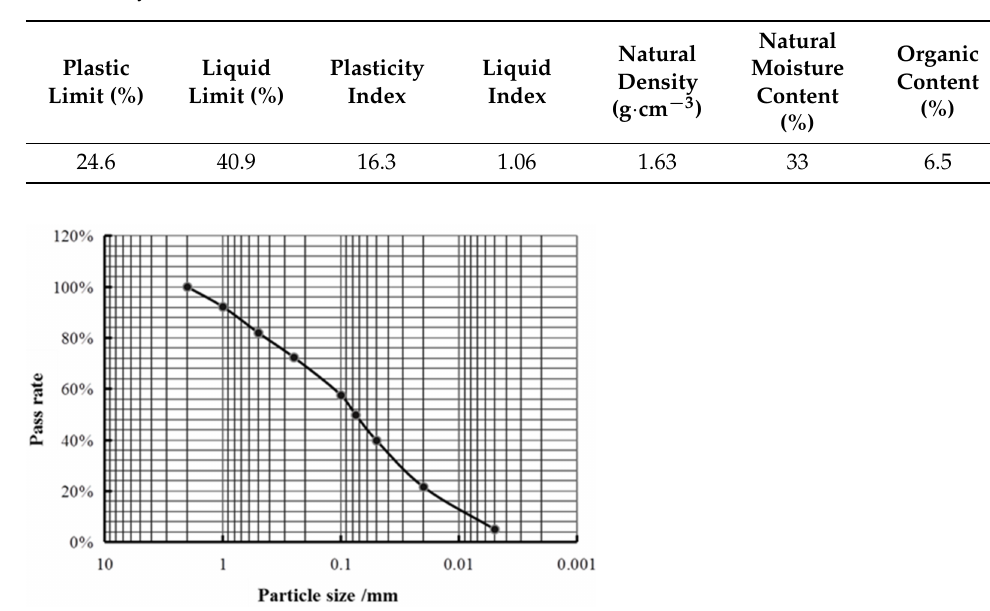
Table 3. Physical indicators of soil.